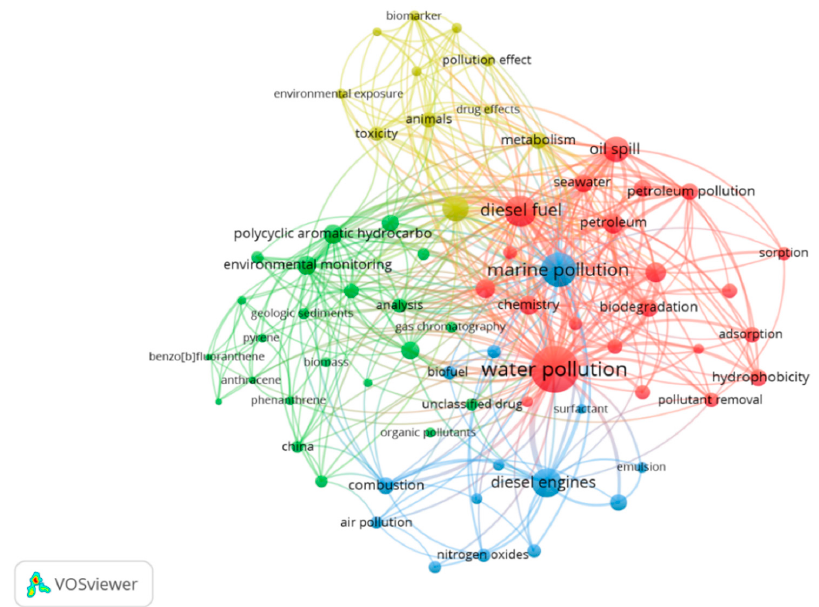
Figure 2. Co-occurrence mapping based on keyword plus (min. number of occurrences: Five).